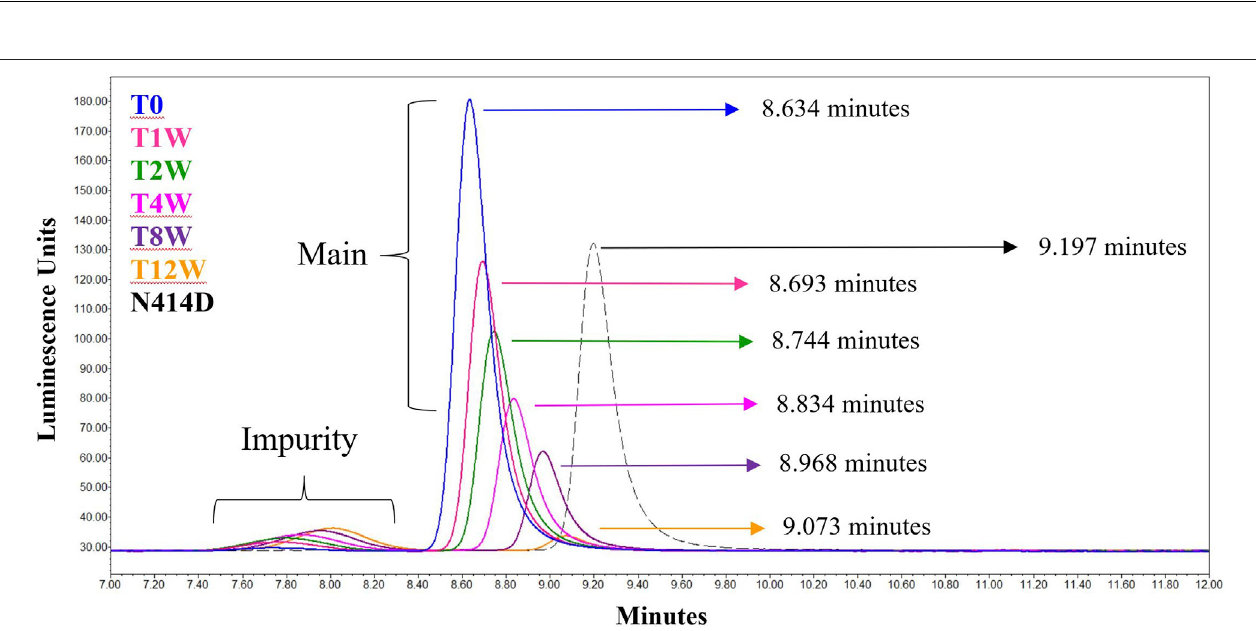
FIGURE 4 | Deamidation level of selected hexon asparagine residues from the 0- and 12-weeks accelerated stability unfractionated samples and the associated “ Impurity ” and “ Main ” peaks fractions.